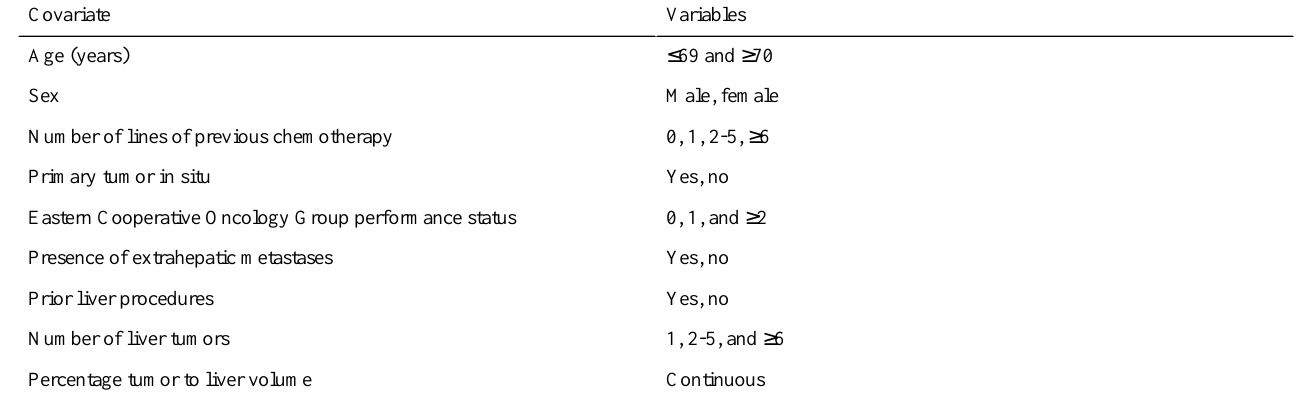
Table 2. Covariates for time to event end